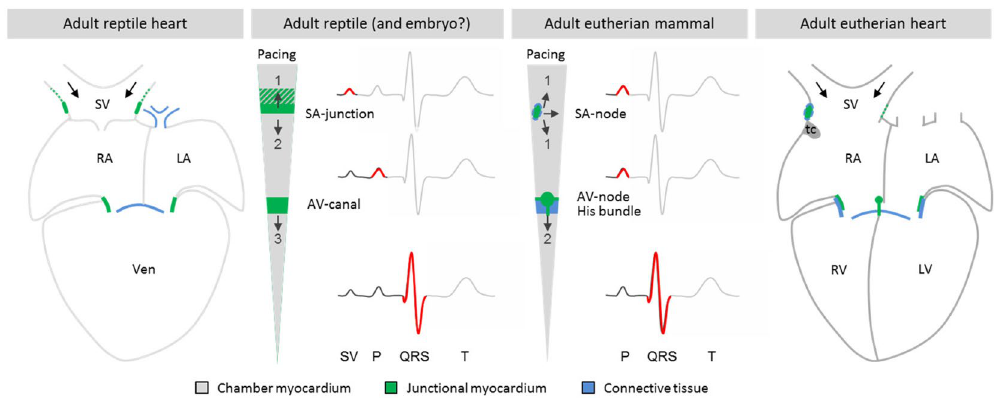
Figure 7. The sinuatrial junction of reptiles and mammals. Reptiles have a sinuatrial junction which harbors the dominant pacemaker and establishes a delay between the electrical activation of the sinus venosus and the atria. This enables the sinus venosus to function as a chamber that aids the filling of the right atrium. In eutherian mammals, the sinuatrial junction is remodeled and the sinuatrial delay is lost as revealed on the ECG by the absence of a sinus venosus wave. The sinus venosus of embryonic mammals may function much like in reptiles, and the mammalian sinus node develop from tissues with a similar phenotype as the reptilian sinuatrial